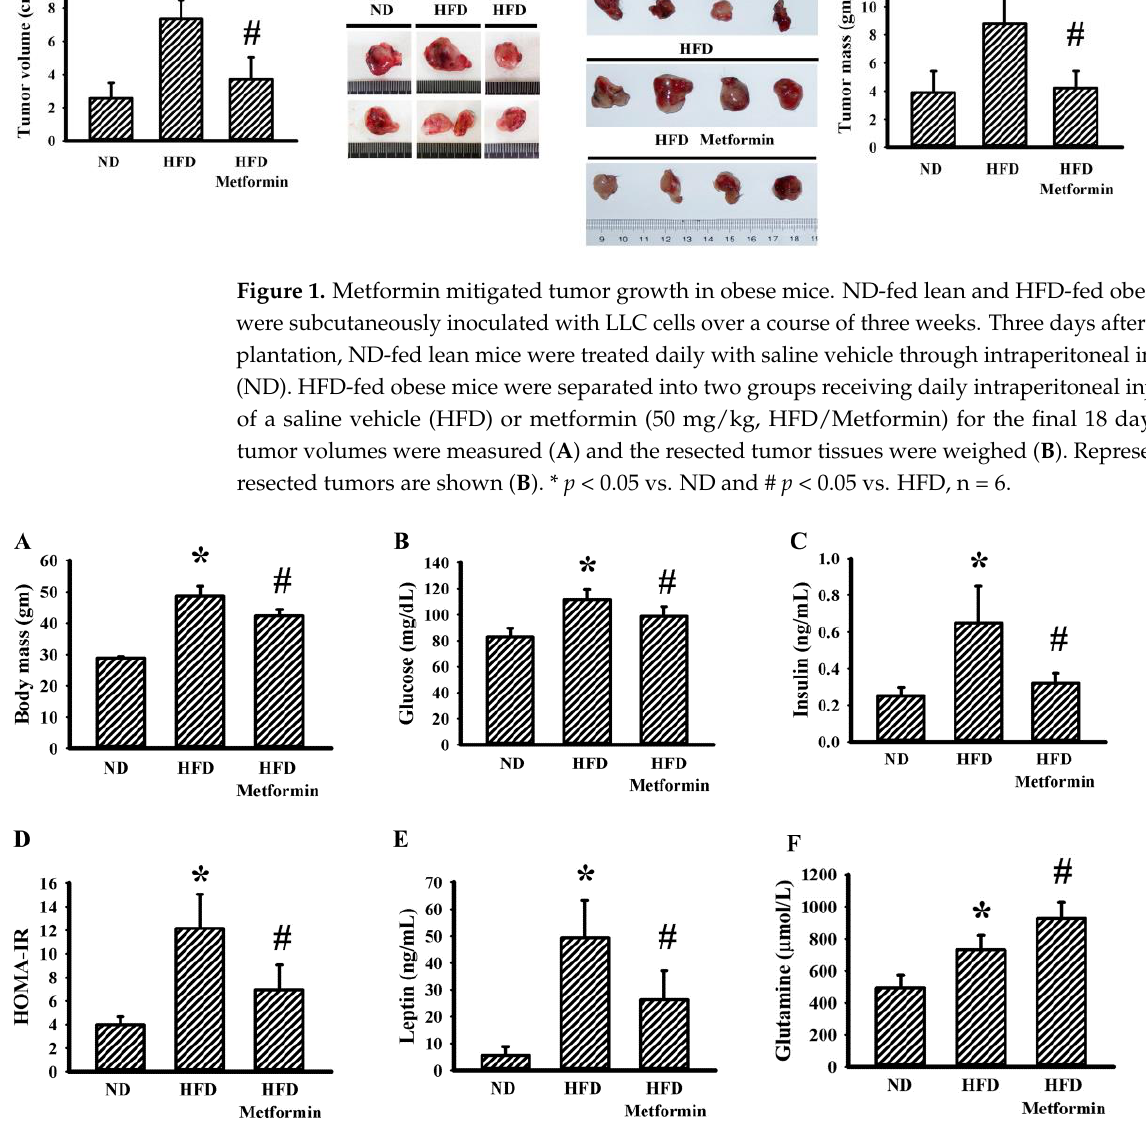
Figure 2. Metformin mitigated metabolic alterations in obese mice. ND-fed lean and HFD-fed obese mice were subcutaneously inoculated with LLC cells over a course of three weeks. Three days after cell implantation, ND-fed lean mice were treated daily with saline vehicle through intraperitoneal injection (ND). HFD-fed obese mice were separated into two groups receiving daily intraperitoneal injections of a saline vehicle (HFD) or metformin (50 mg/kg, HFD/Metformin) for the final 18 days. Body mass ( A ), fasting glucose ( B ), fasting insulin ( C ), HOMA-IR ( D ), plasma leptin ( E ) and plasma glutamine ( F ) were all determined. * p < 0.05 vs. ND and # p < 0.05 vs. HFD, n = 6.